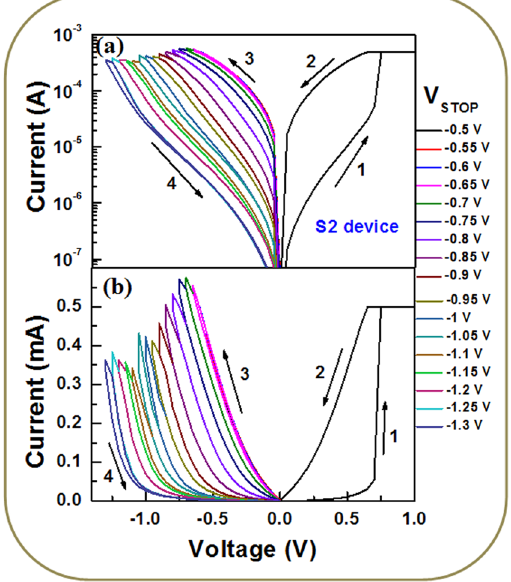
Figure 6. One time SET and staircase RESET by varying negative stop voltage of the S2 devices with a size of 0.4 × 0.4 µ m 2 . I-V characteristics using ( a ) log and ( b ) linear